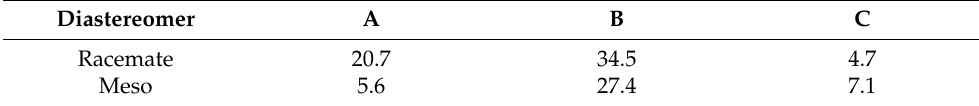
Table 4. Ratio of rotamers A–C (%) for mixture of diastereomers of 2 in CDCl 3 at 23 ◦ C.